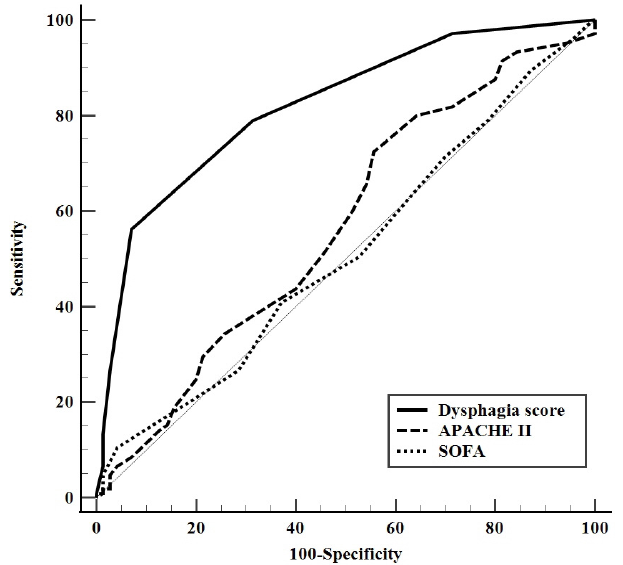
Figure 2. The number of patients for the dysphagia score and corresponding dysphagia rate at hospital discharge.